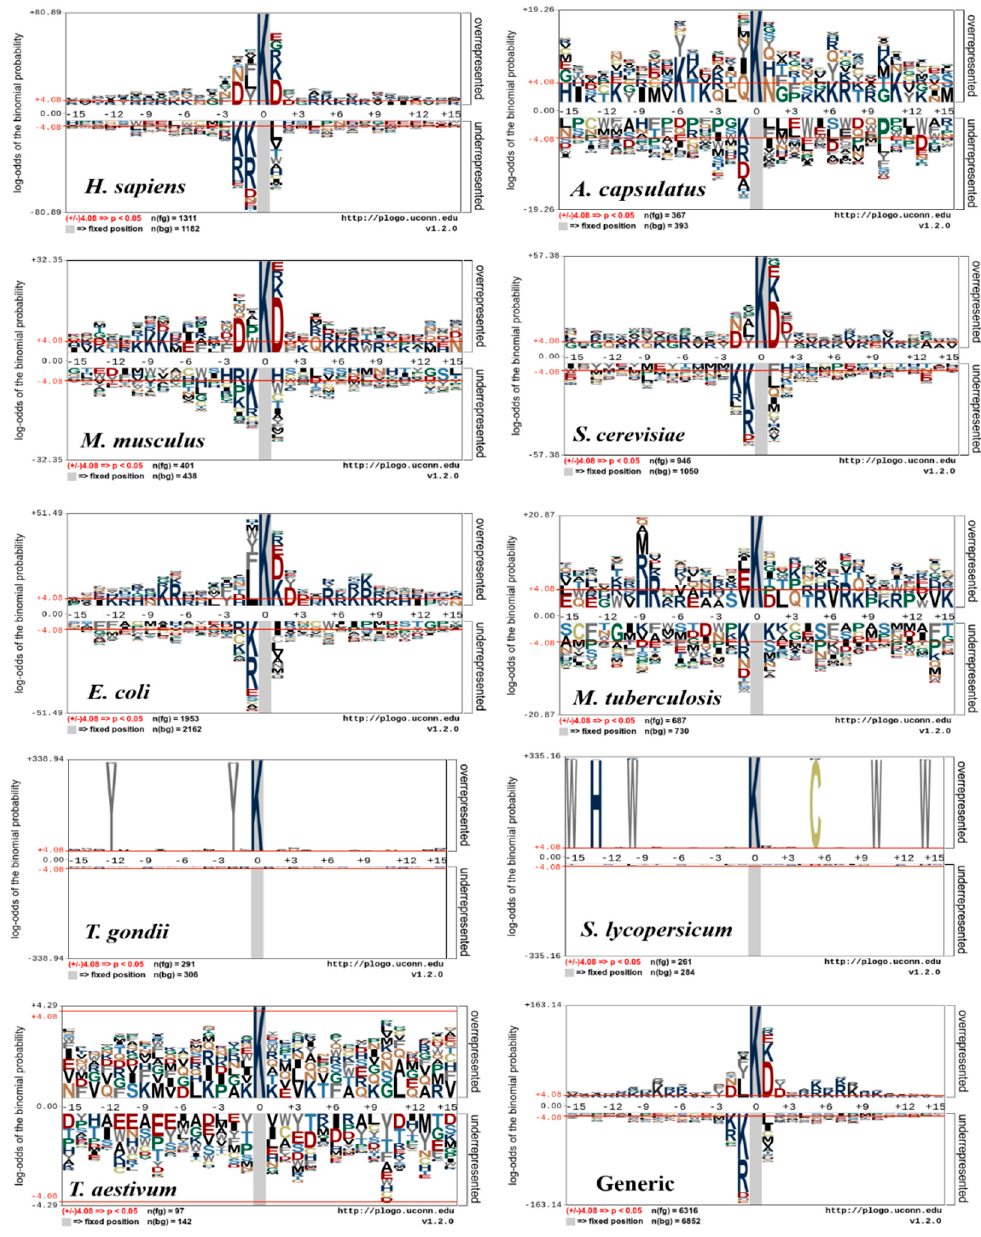
Figure 3. pLogo graphs of the sequences with the centered succinylation sites. Nine species-specific datasets of H. sapiens , H. capsulatum , M. musculus , E. coli , M. tuberculosis , S. cerevisiae , T. gondii , S. lycopersicum and T. aestivum (https://plogo.uconn.edu/) and their combined (generic) datasets are used. The significantly enriched/depleted amino acid residues (student t -test, p < 0.05) are shown.